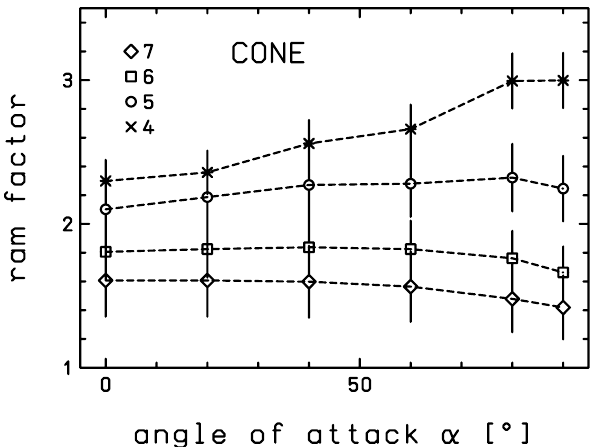
Fig. 2. Ram-factors for CONE as a function of the angle of attack measured for different flow conditions. The different results are labeled according to the flow condition number given in Table 3.